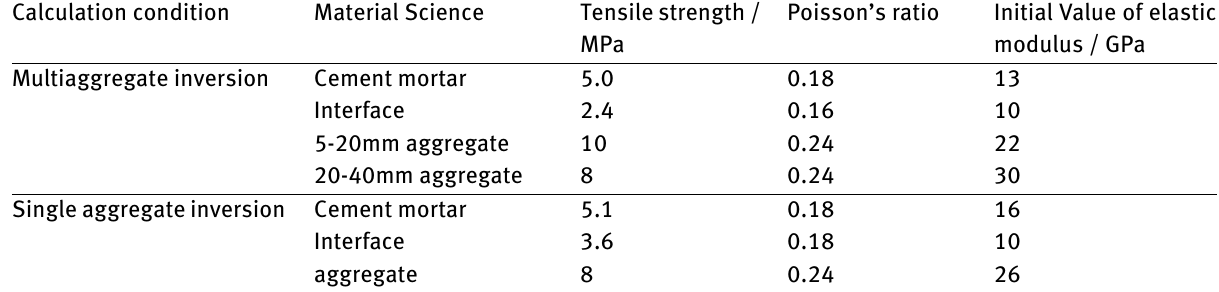
Table 3: Inversion results of material micro components